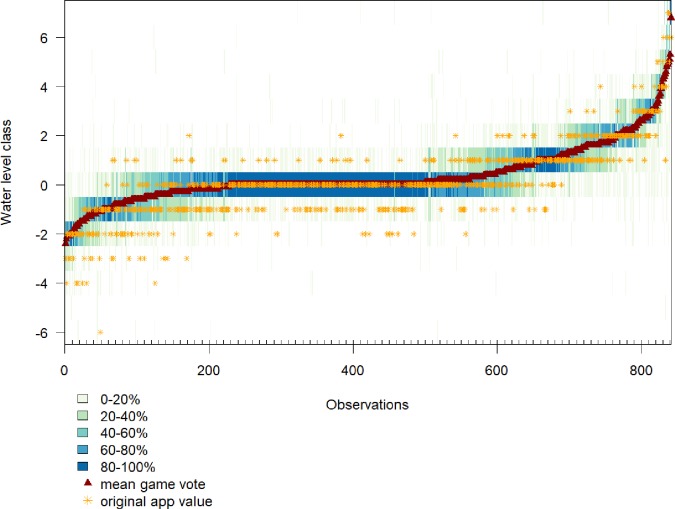
Agreement among players (in %) per classified observation.Each column represents one observation, sorted according to the mean game vote (red triangle). Darker colours represent a higher agreement and lighter colours a lower agreement among the players. The original value of the water level class submitted via the app is indicated by the orange star.